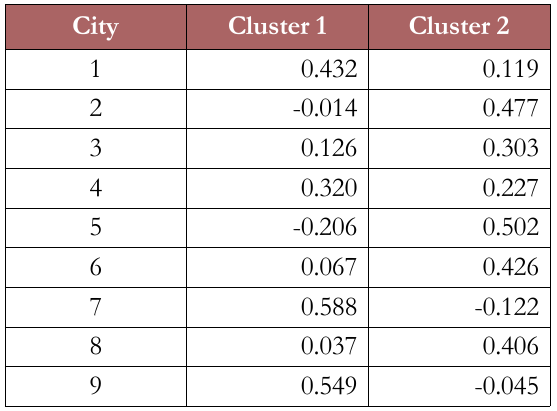
Table 6. Final clusters of the hypothetical